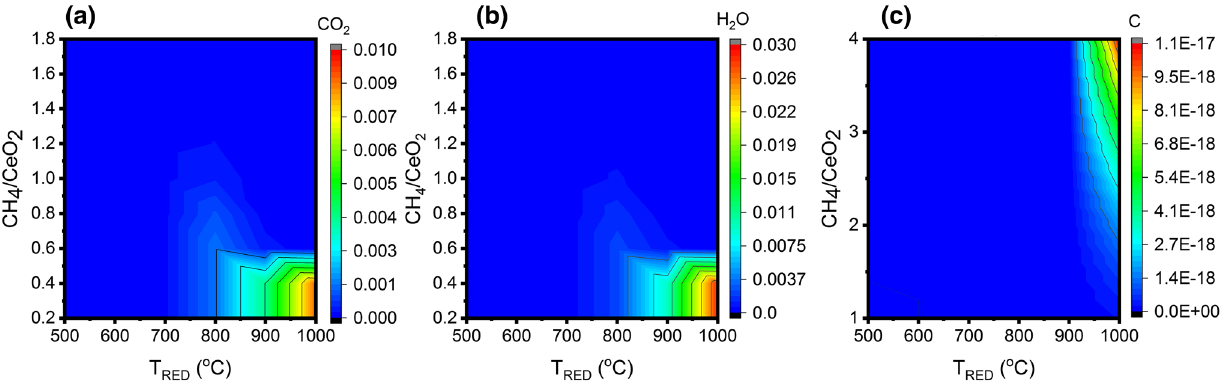
Fig. 4 Impact of the variation of the CH 4 /CeO 2 ratio and temperature on the yield of the following unwanted chemical species as molar fraction of the outlet product streams within the reduction reactor: a CO 2 ; b H 2 O; c elementary carbon